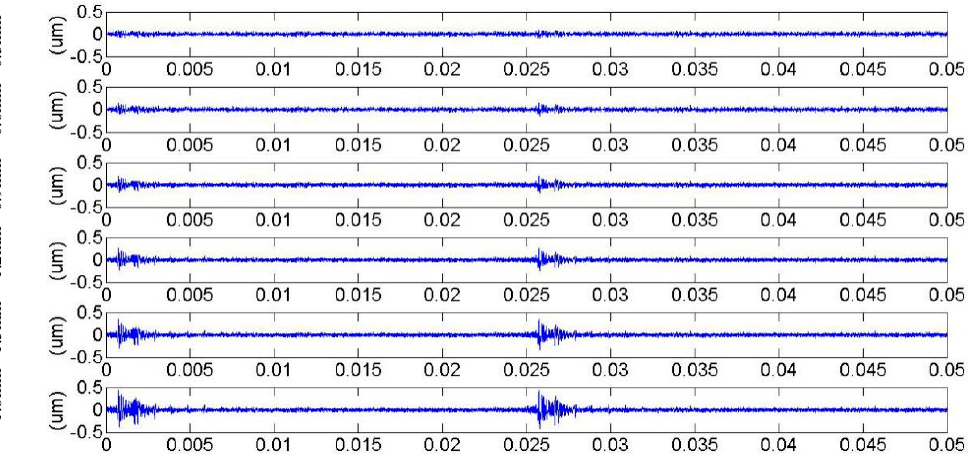
Figure 9. Meshing stiffness of the 25° pressure angle.